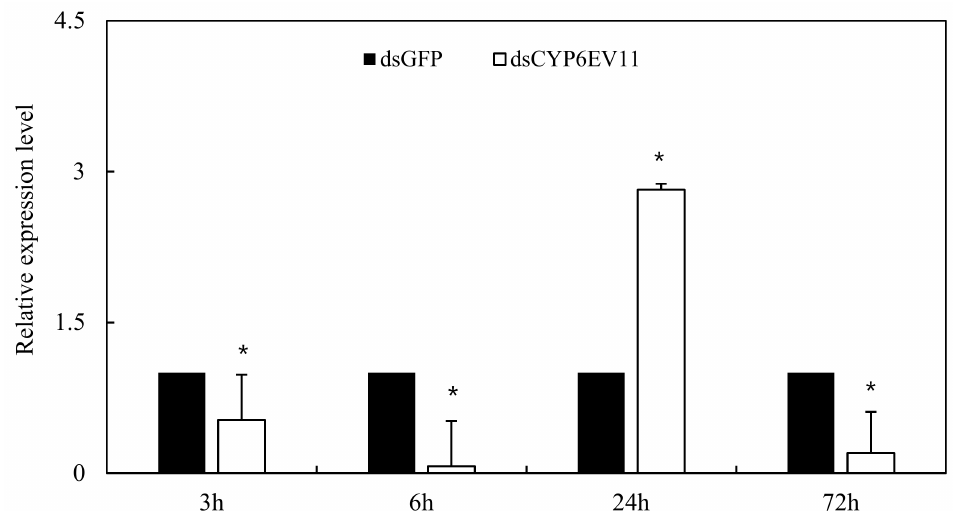
Figure 4. The CYPEV11 transcriptional level in C. kiiensis soaked in dsCYPEV11 compared with those soaked in dsGFP . The asterisk (*) on the SE bars indicate significant differences between treatments and controls ( p < 0.05).